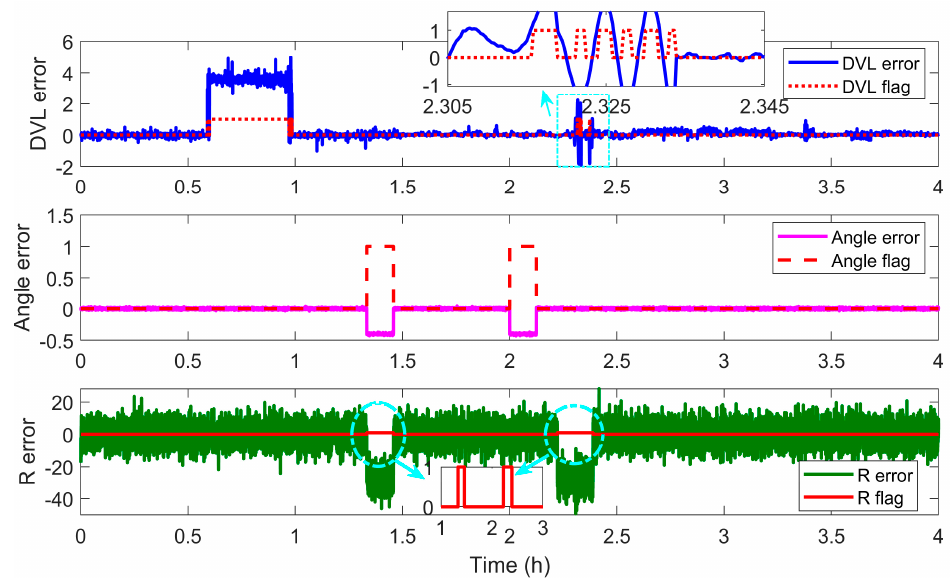
Figure 13 . Description of the fault detection flags.